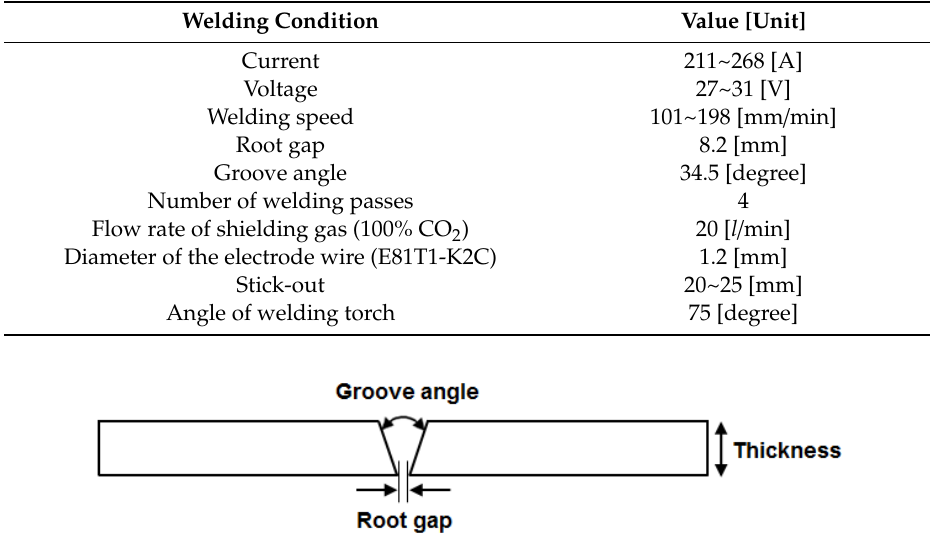
Figure 5. Definition of root gap and groove angle.